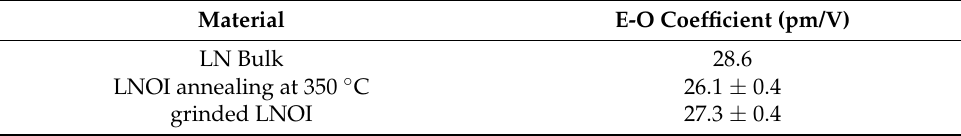
Figure 9. ( a ) Variation of output light power with time after applying voltages of 5 and 0 V on electrodes. ( b ) 200 kHz triangular wave sweep with amplitude of 18 V for 5-mm-long phase modulator. Black line, triangular wave signal; red line, detector signal. Table 2. The E-O coefficients of LN bulk and LNOI ( λ = 1550 nm).